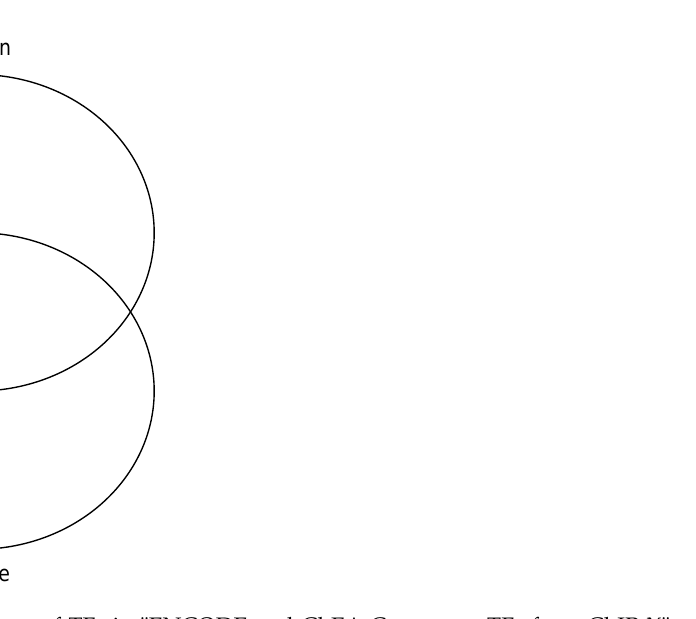
Figure 5. Venn diagram of TFs in "ENCODE and ChEA Consensus TFs from ChIP-X" category, selected by uploading genes selected by TD-based unsupervised FE to